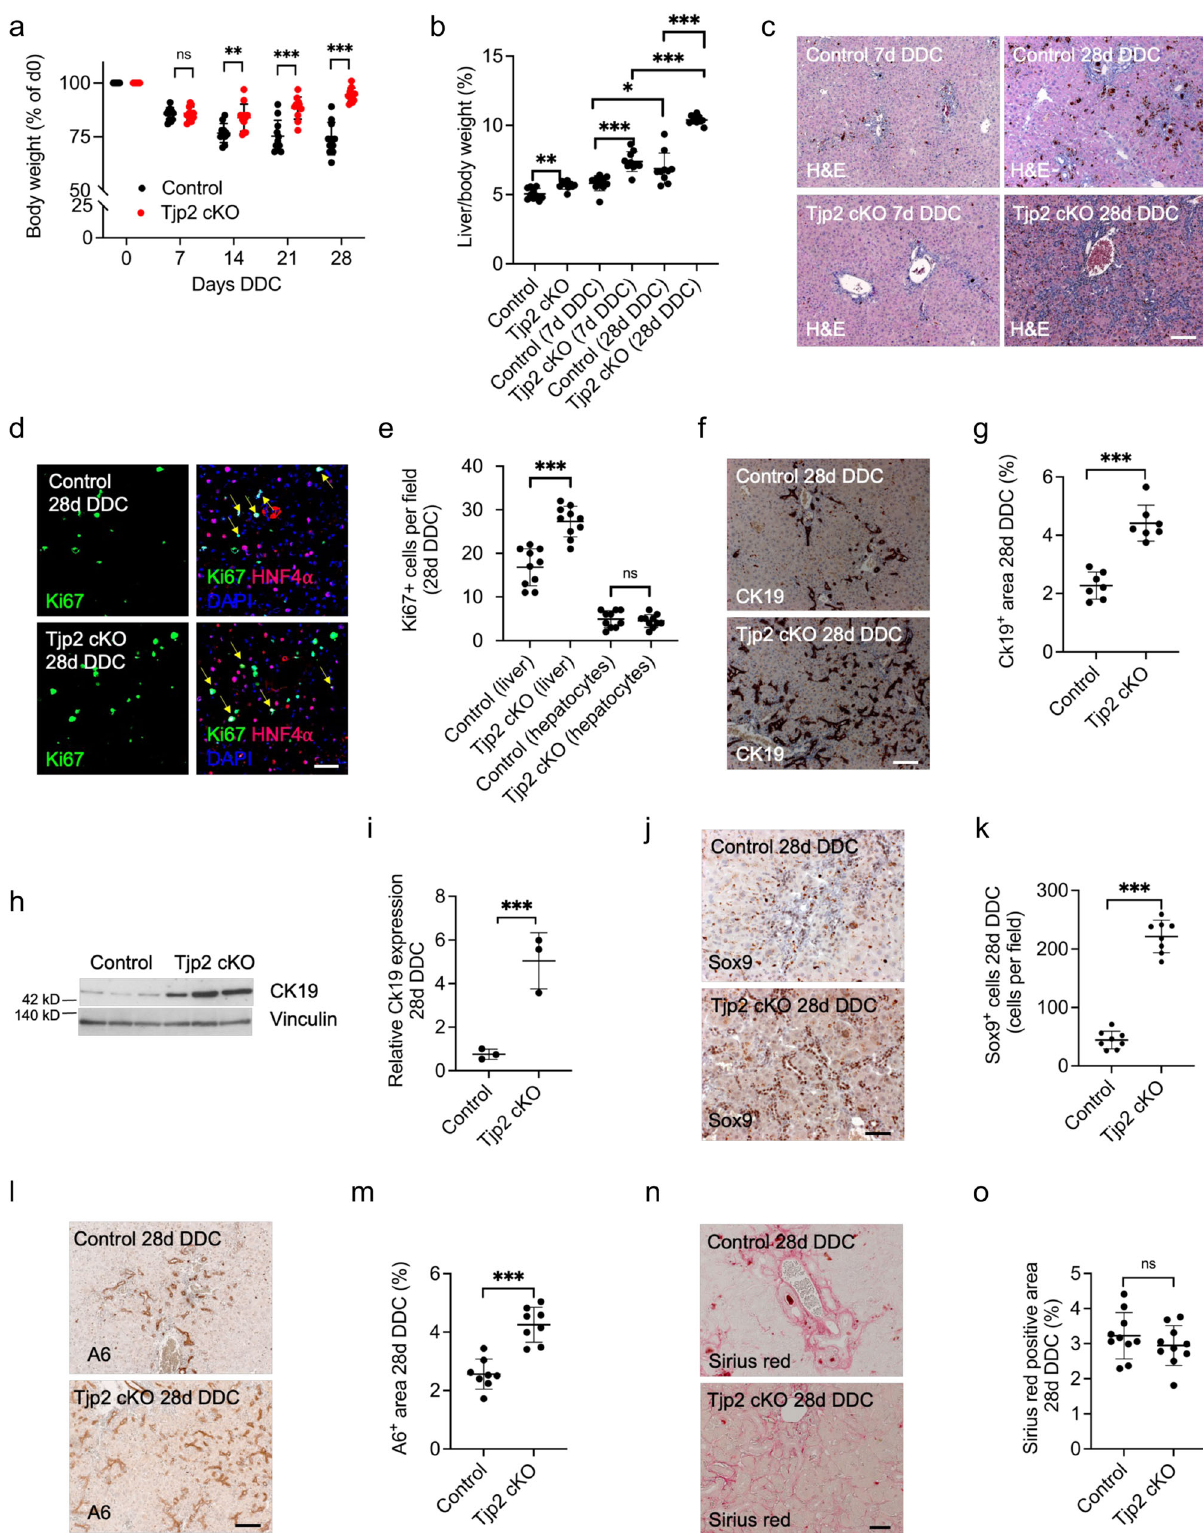
corroborating the LacZ lineage tracing experiment. The data thus indicates that following inactivation of Tjp2 in hepatocytes, the DDC diet induces a strong ductular reaction, whereby new cholangiocytes arise by transdifferentiation of